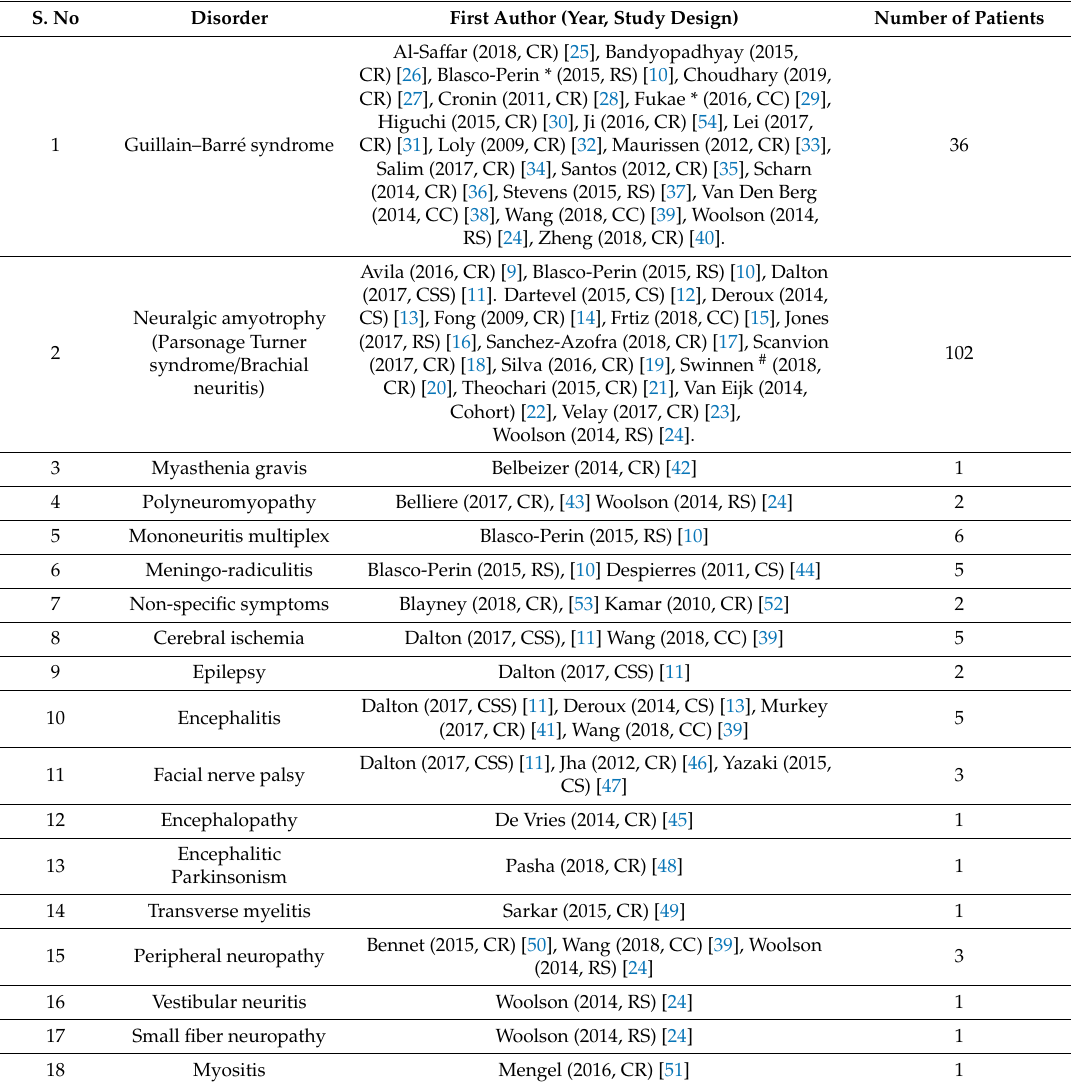
Table 1. Extra-hepatic neurological and musculoskeletal manifestations of hepatitis E infection. S.